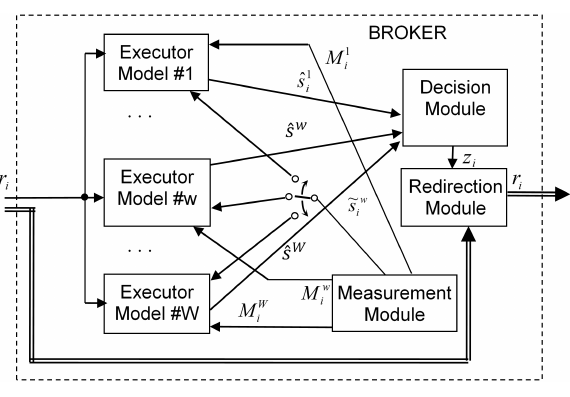
Fig. 2. Broker design.